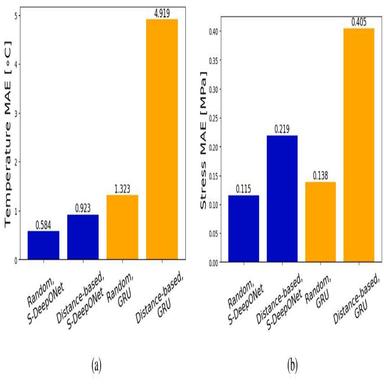
Comparison of MAE for temperature and stress predictions using S-DeepONet and GRU model.